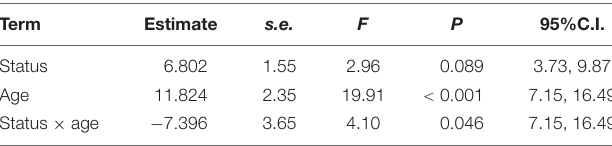
TABLE 6 | Results of LMMs for number of spots of common kestrel males as a function of dispersal status (immigrant vs. resident), age (young vs. adult), and the interaction between dispersal status and